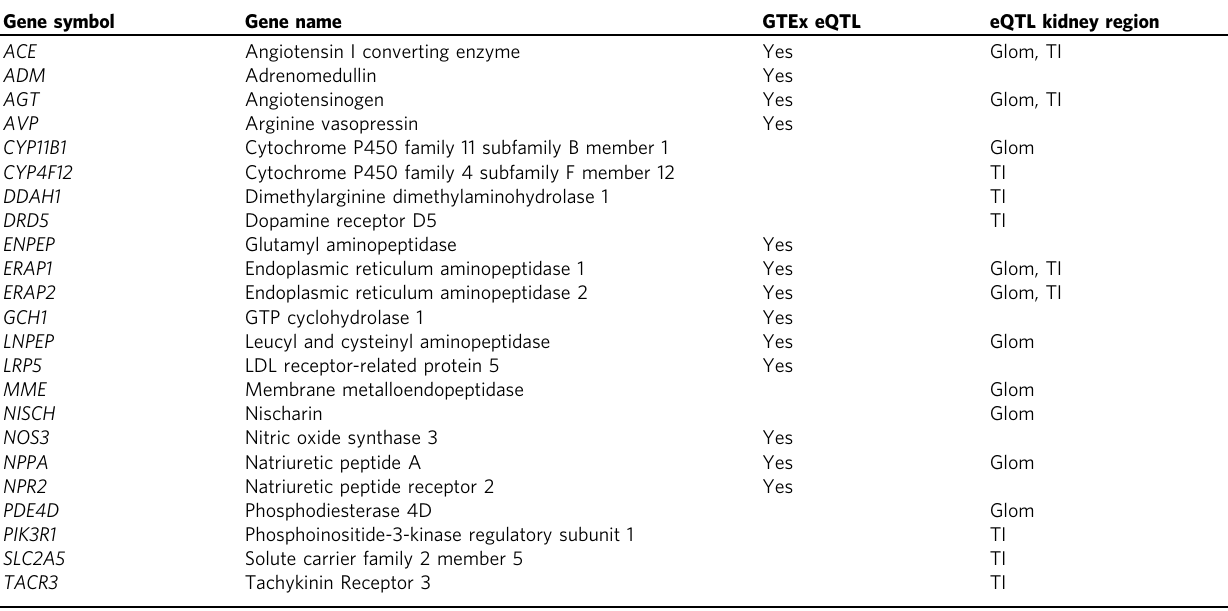
GTEx Genotype-Tissue Expression Project, eQTL expression quantitative trait locus, Glom glomerulus, TI renal tubulointerstitial compartment. a These genes are known to be involved in intermediary metabolism or mitochondrial function based on the gene functional annotation retrieved using the Database for Annotation, Visualization and Integrated Discovery(DAVID).In addition,these genesare eQTLgenesfor humanbloodpressure-associated single-nucleotidepolymorphisms withgenome-widesigni fi cance, and theyare knownto be physiologically important for blood pressure regulation based on Gene Ontology 42